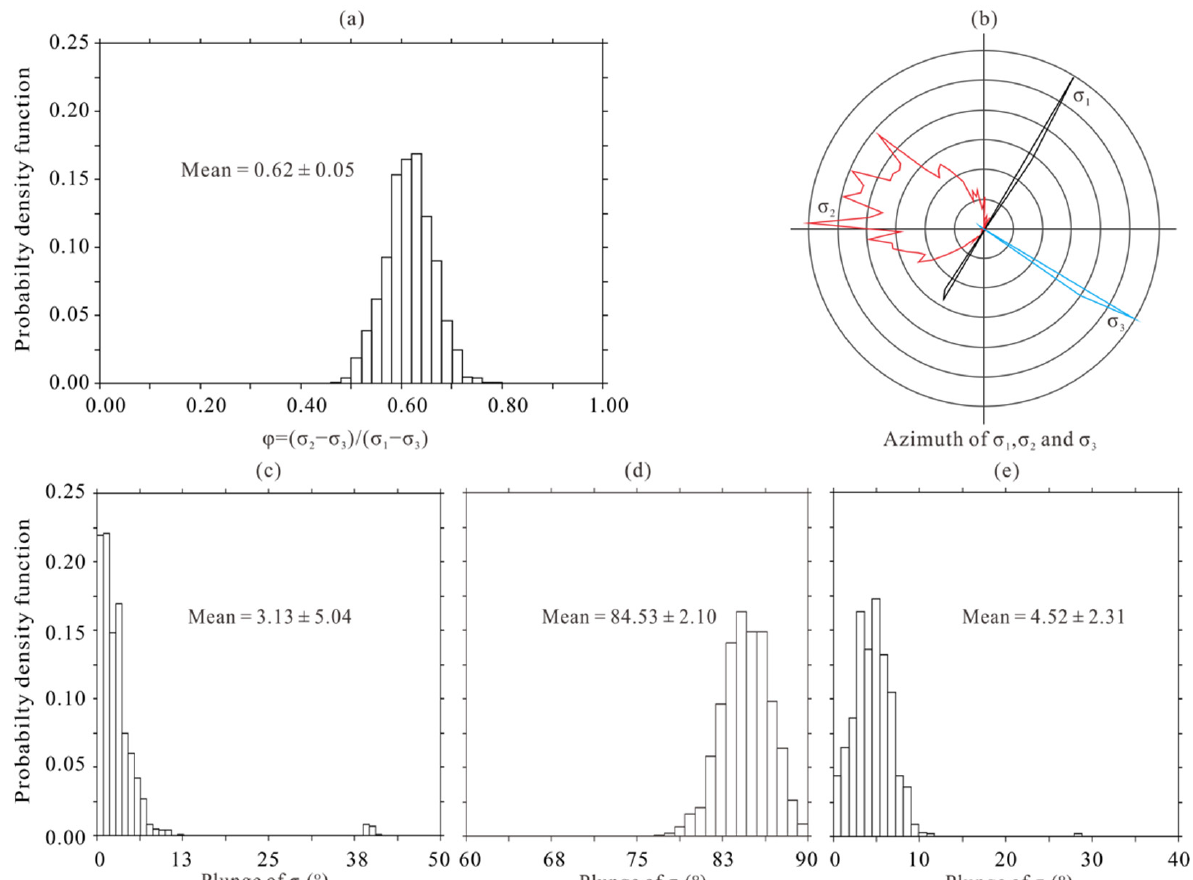
Figure 4. Map of the stress field inversion results of the M S 5.0 Yingjiang earthquake in 2021. ( a ) Probability density function of the principal stress shape ratio; ( b ) azimuth distribution of the prin- cipal stress axis; ( c – e ) probability density function of the plunge angles of principal stresses 𝜎 (cid:2869) , 𝜎 (cid:2870) , and 𝜎 (cid:2871) .